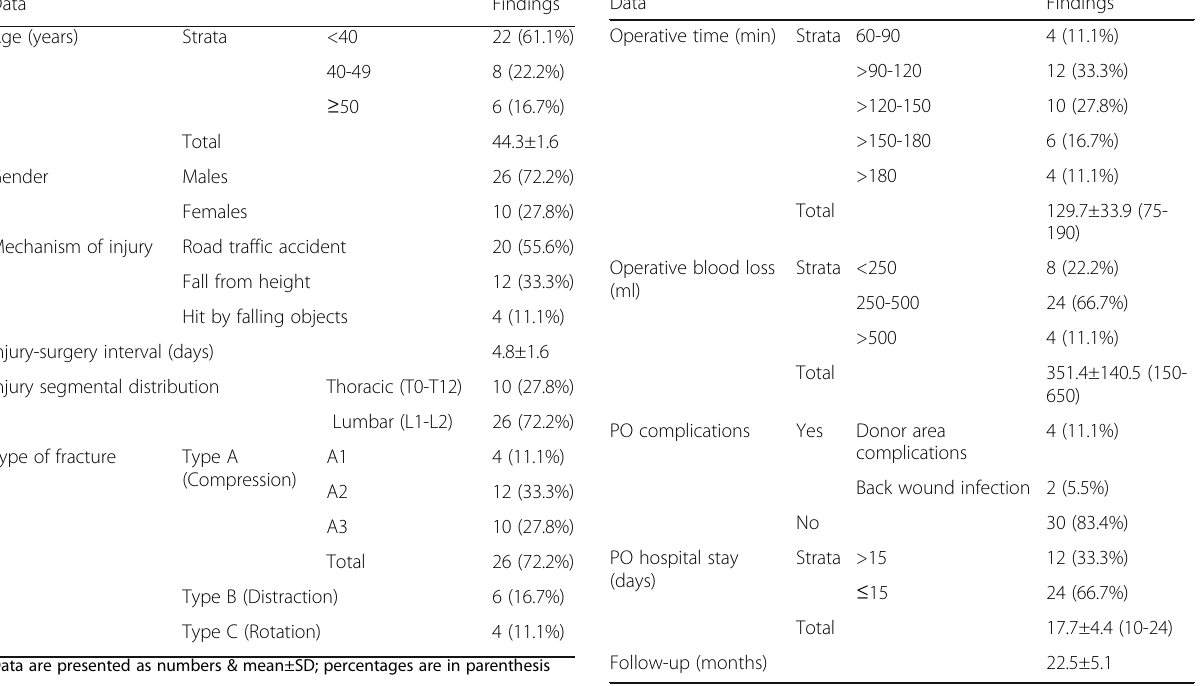
Table 2 Enrolment data of studied patients Data